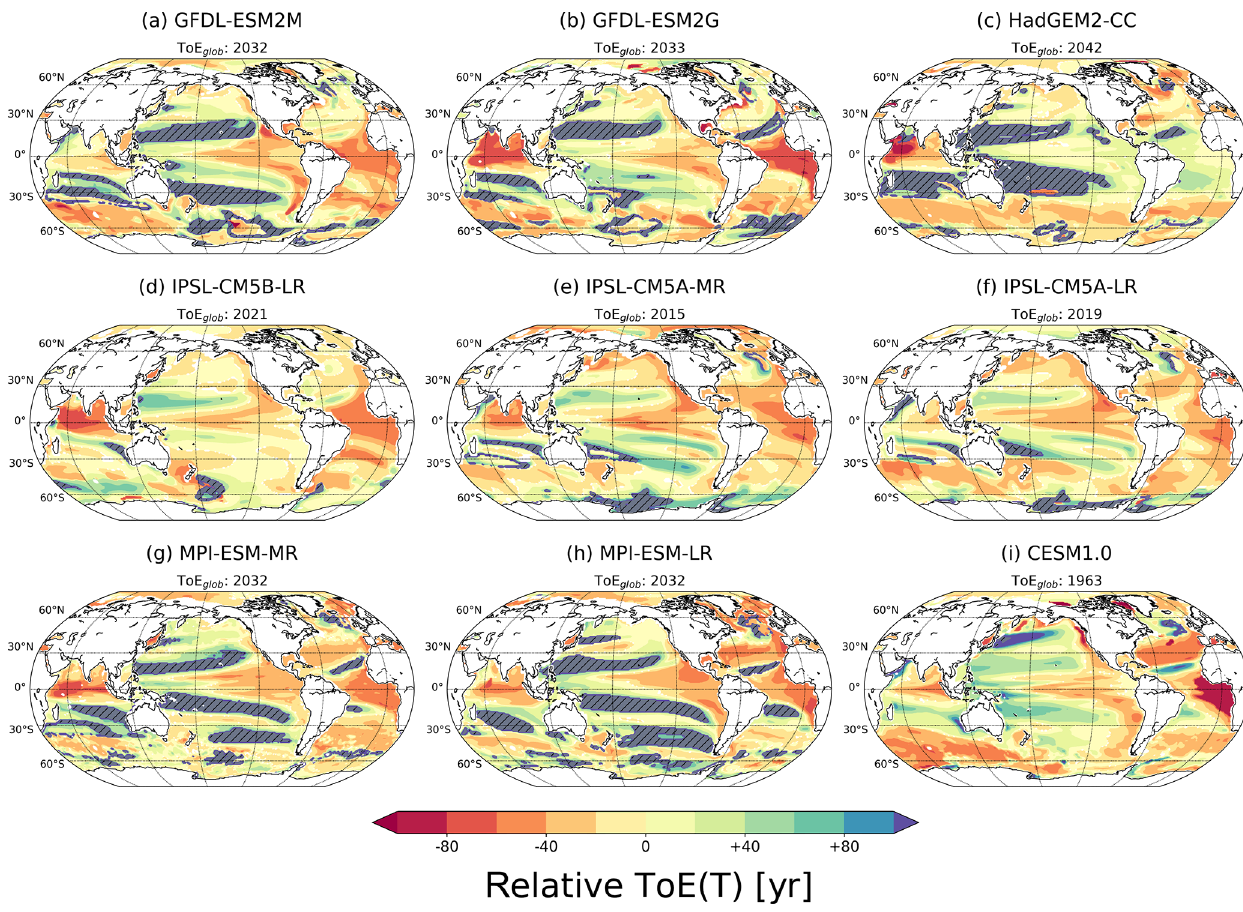
Figure 2. ToE of T in the thermocline (200–600m) relative to the averaged ToE in that layer for each simulation. The hatched areas show regions with no emergence by the end of the 21st century. The values of the global average ToE, ToE glob , are given above each panel. The absolute ToE estimates are shown in Fig.